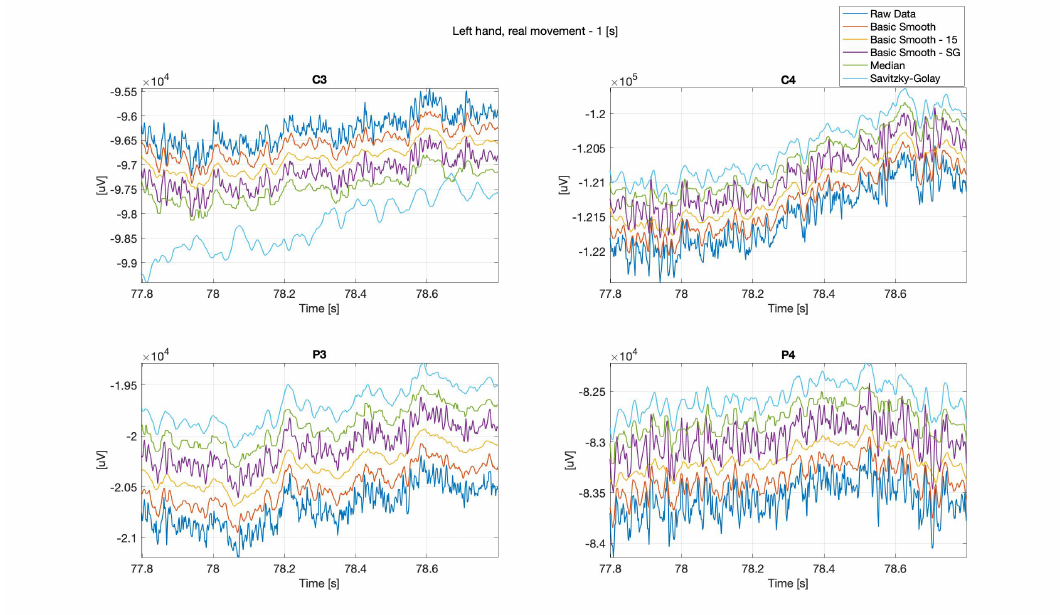
Figure 3. Left hand, real movement, C3, C4, P3 and P4 channels.